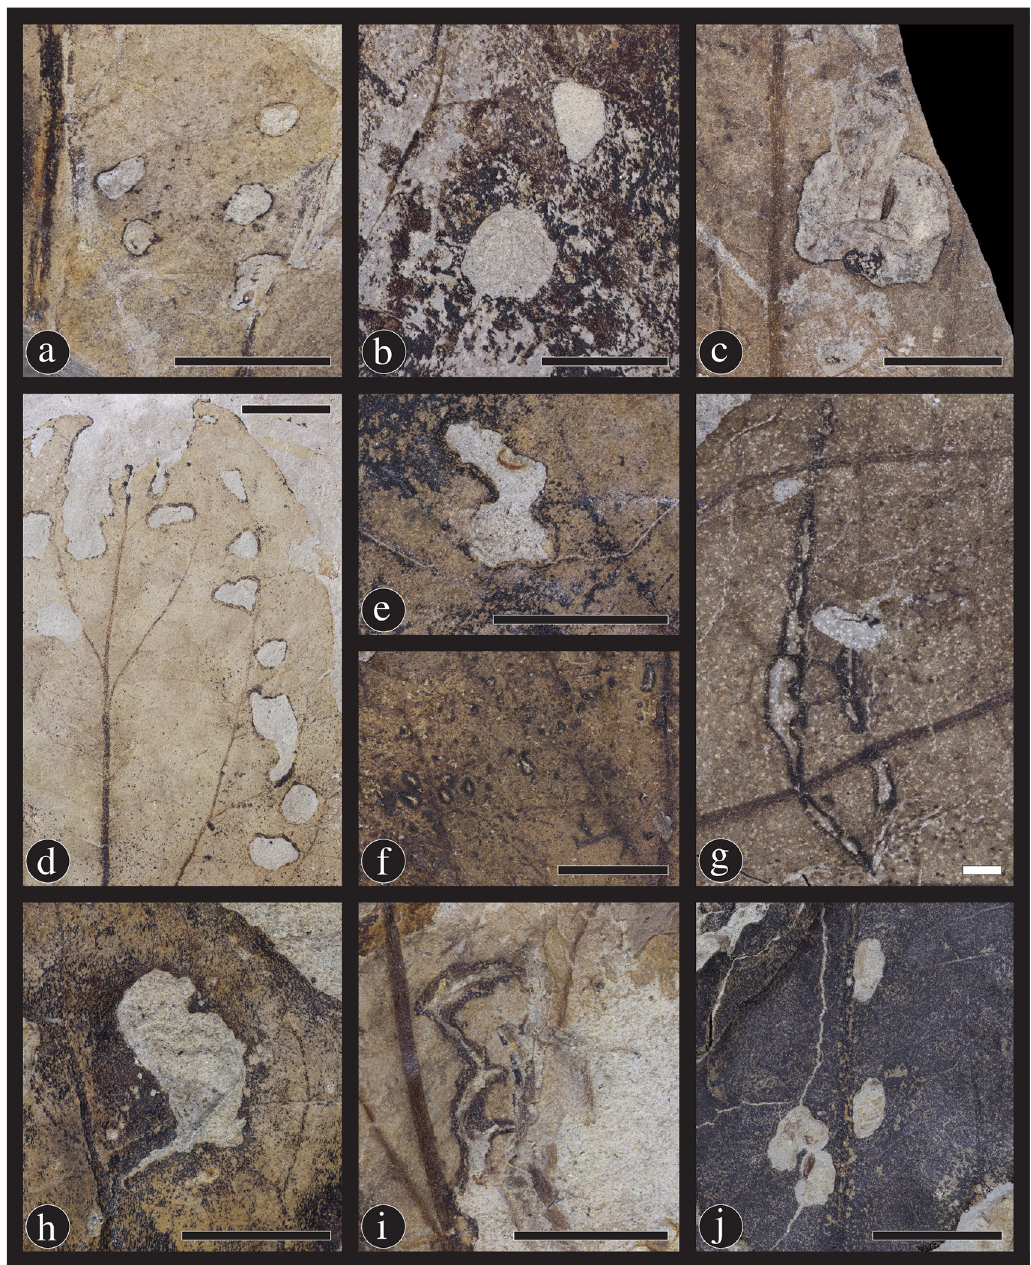
Fig 8. Eleven hole-feeding damage types found on Catula gettyi produced by mandibulate insects. (A) DT1; Circular holes under 1mm in diameter (DMNH 41564); (B) DT2; Circular holes between 1 mm and 5 mm in diameter (DMNH 41580); (C) DT4; Circular holes greater than 5 mm in diameter (DMNH 41596); (E) DT3; Polylobate holes between 1 mm and 5 mm in diameter (DMNH 41576); and (H) DT5; Large polylobate holes over 5 mm in diameter (DMNH 41583). Less common hole- feeding types consist of (G) DT7 & DT8 (DMNH 41590); Rectilinear holes and slot feeding, respectively (DMNH 41590); (F) DT9; Scattered, comma-shaped holes (DMNH 39733); (D) DT64; Holes located along the margin of the leaf (DMNH 41584); (I) DT51; Overlapping slot feeding holes (DMNH 41571); and (J) DT50; A series of holes associated with a primary vein (DMNH 41574). Black scale bars = 5 mm; white scale bars = 1 mm.